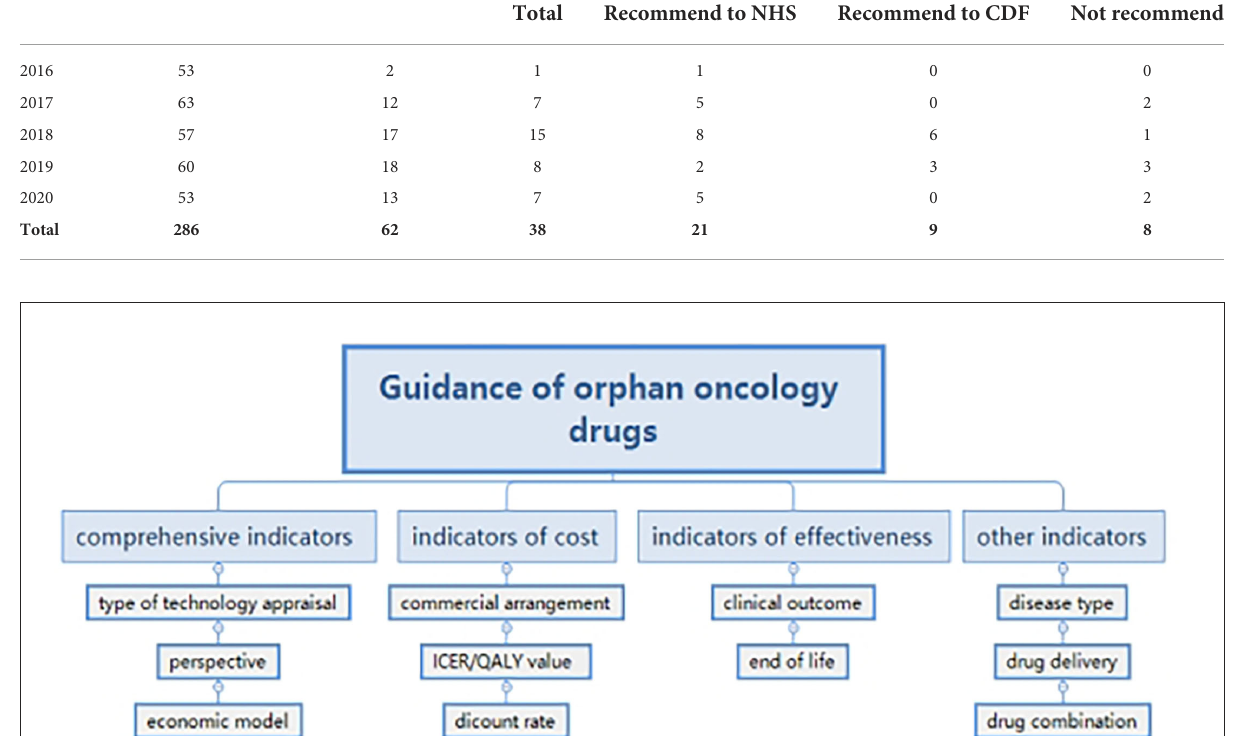
FIGURE1 Methodological